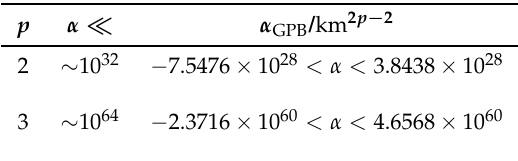
Table 2. The numerical constraints for the constant α for the power-law model f ( T ) = T + α T p , where p = 2, 3 are set based on the Gravity Probe B observations. Furthermore, an order of magnitude estimate, where the weak-field approximation is valid, has also been